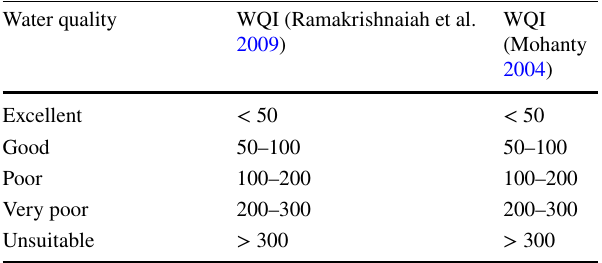
Table 9 Water quality scale Water quality